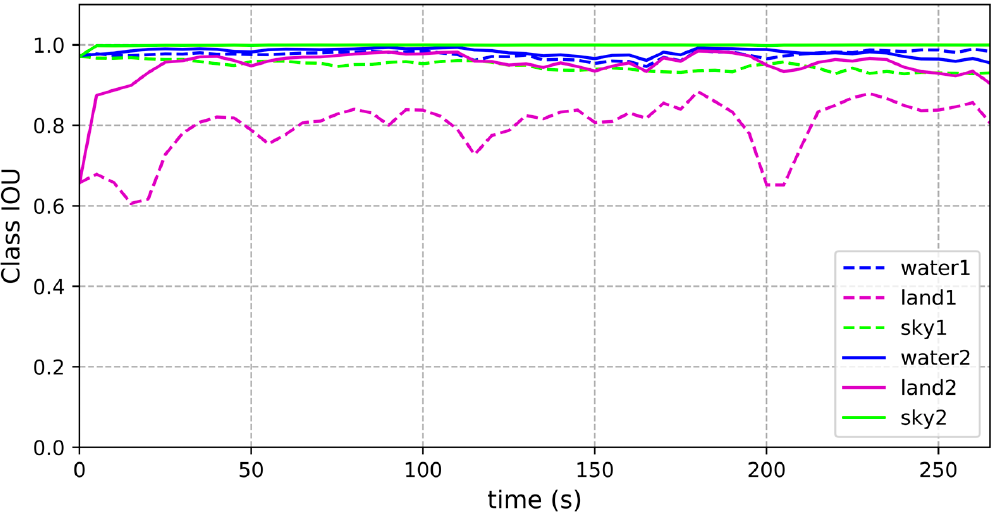
Figure 6. Performance evaluation of each online learning step.